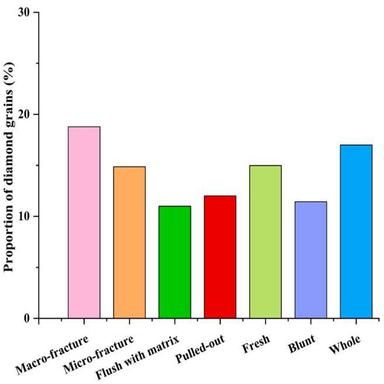
The percentage of each classification of worn DGs.